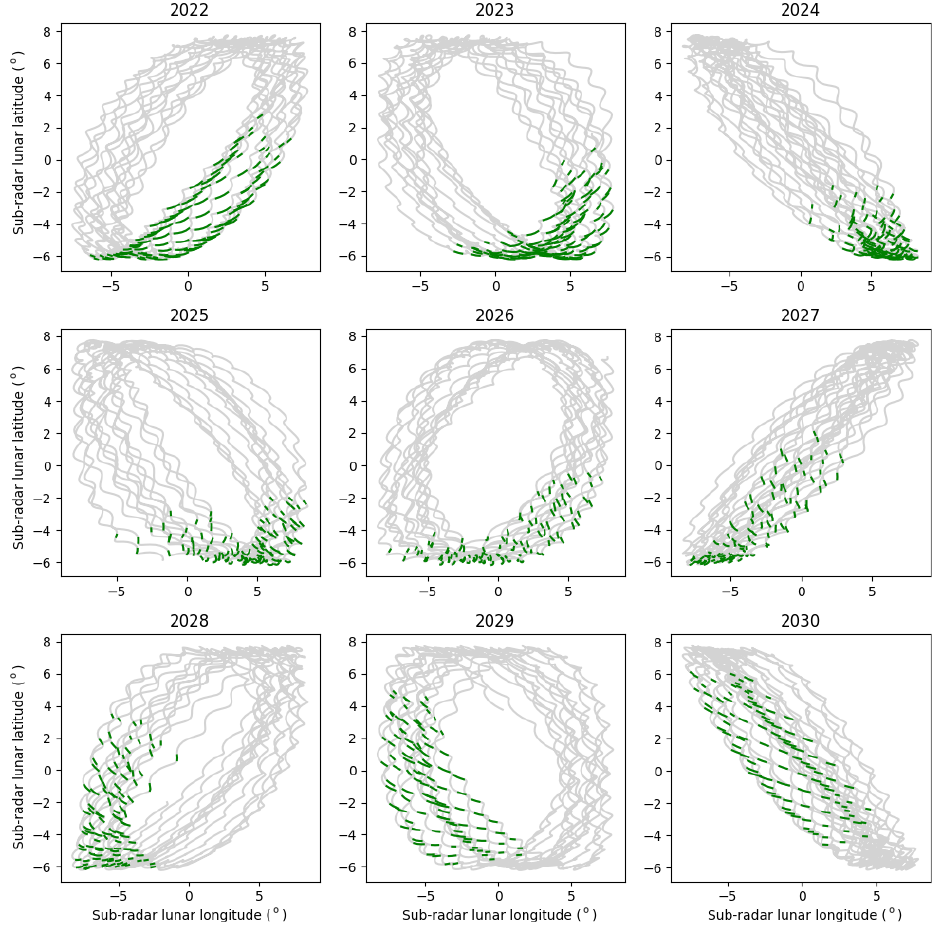
Figure 7. Lunar observation opportunities for 2022–2030. The position of the sub-radar point in selenographic coordinates is shown in light gray. All sub-radar point positions for which the Moon is above 30 ◦ elevation are shown in green. Each year offers a slightly different view of the